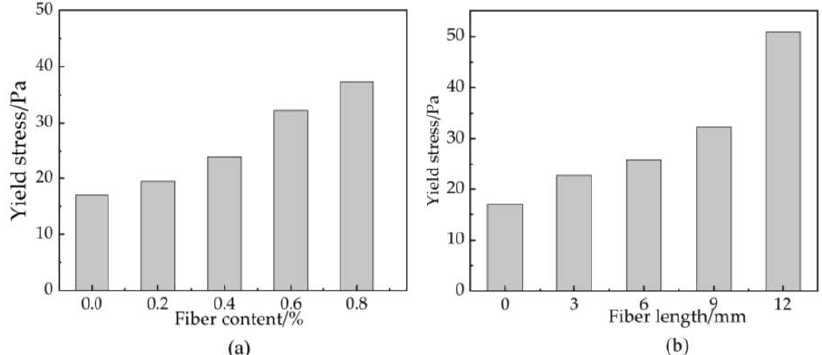
Figure 6. Effect of basalt fiber on the yield stress of BFBCP: ( a ) fiber content, ( b ) fiber